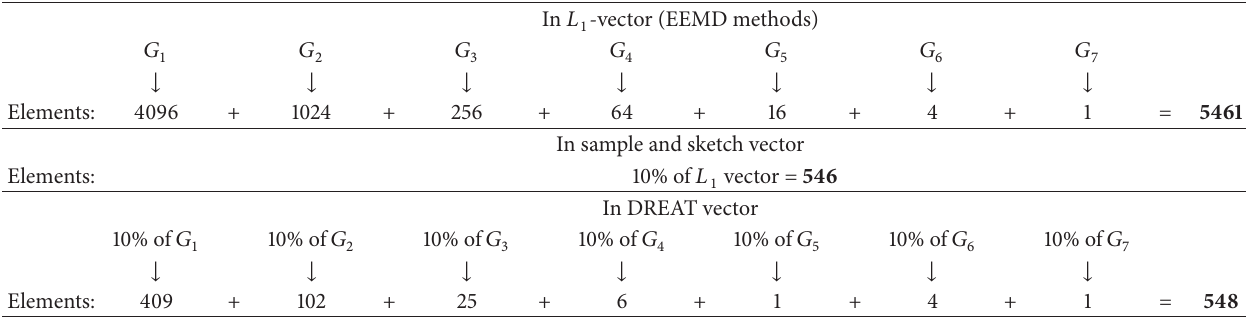
Table 2: Number of vector elements in four methods.